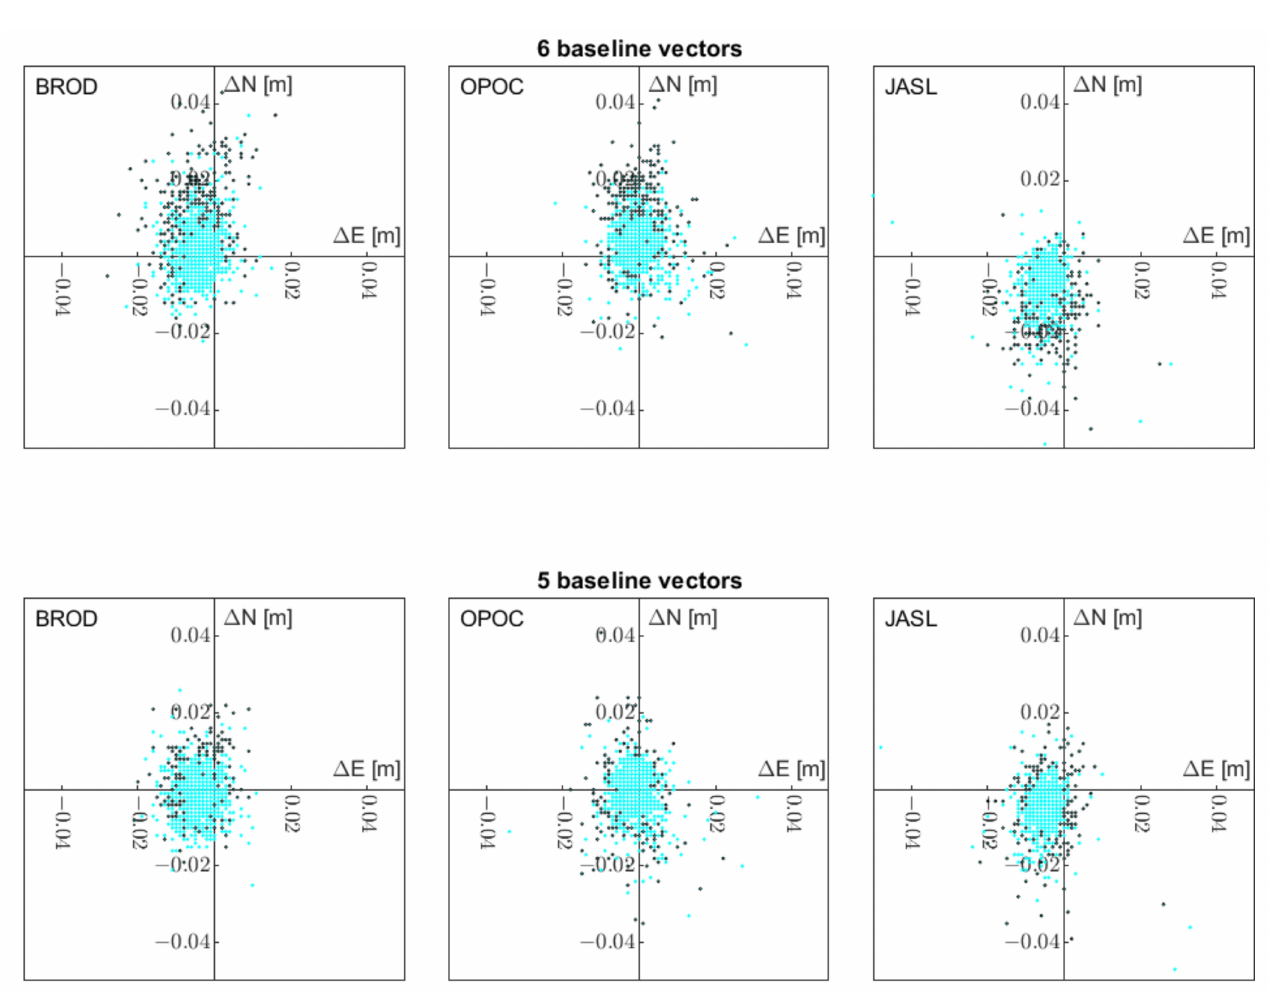
Figure 5. The spatial distribution of positions in the horizontal plane in relation to reference positions of the analysed points for the EAM (black) and UAM (cyan) using baseline vectors to the six and five nearest ASG-EUPOS